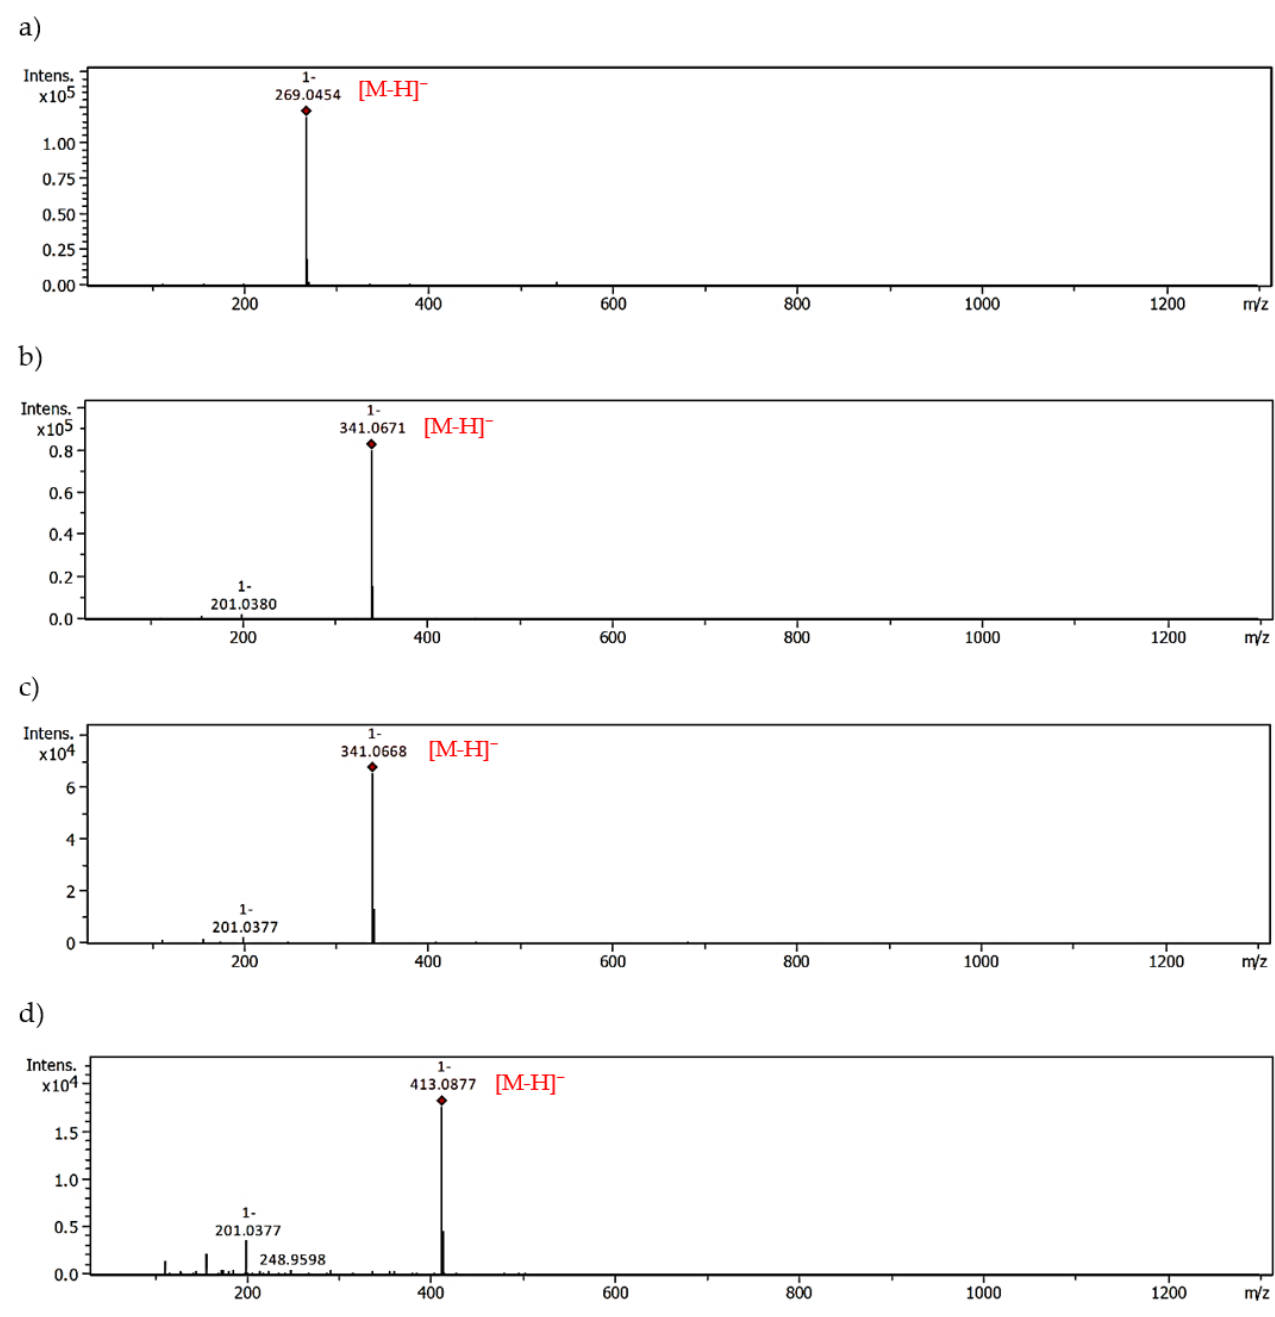
Figure 7. MS spectra of apigenin and apigenin-MGO; ( a ) authentic standard, ( b ) mono-adduct 1, ( c ) mono-adduct 2, ( d ) di-adduct with MGO.